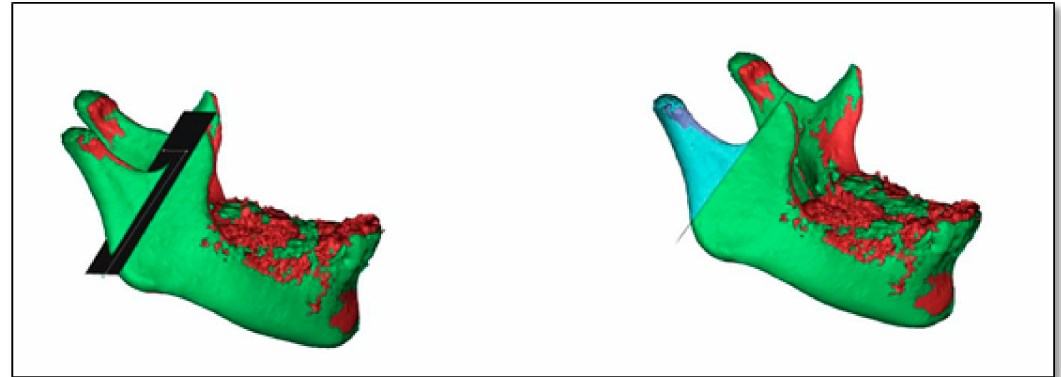
Figure 3. CBCT mandibular 3D images showing construction of plane passing tangent to distal slope of coronoid process to slice right and left condyles of superimposed images using Mimics software.